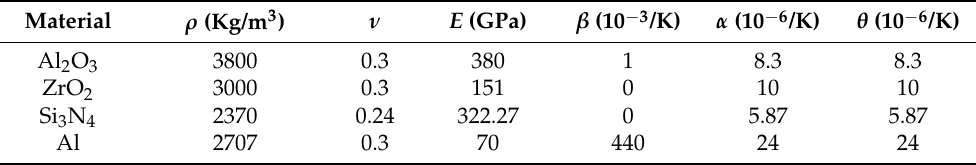
Table 3. FGC material properties [38].